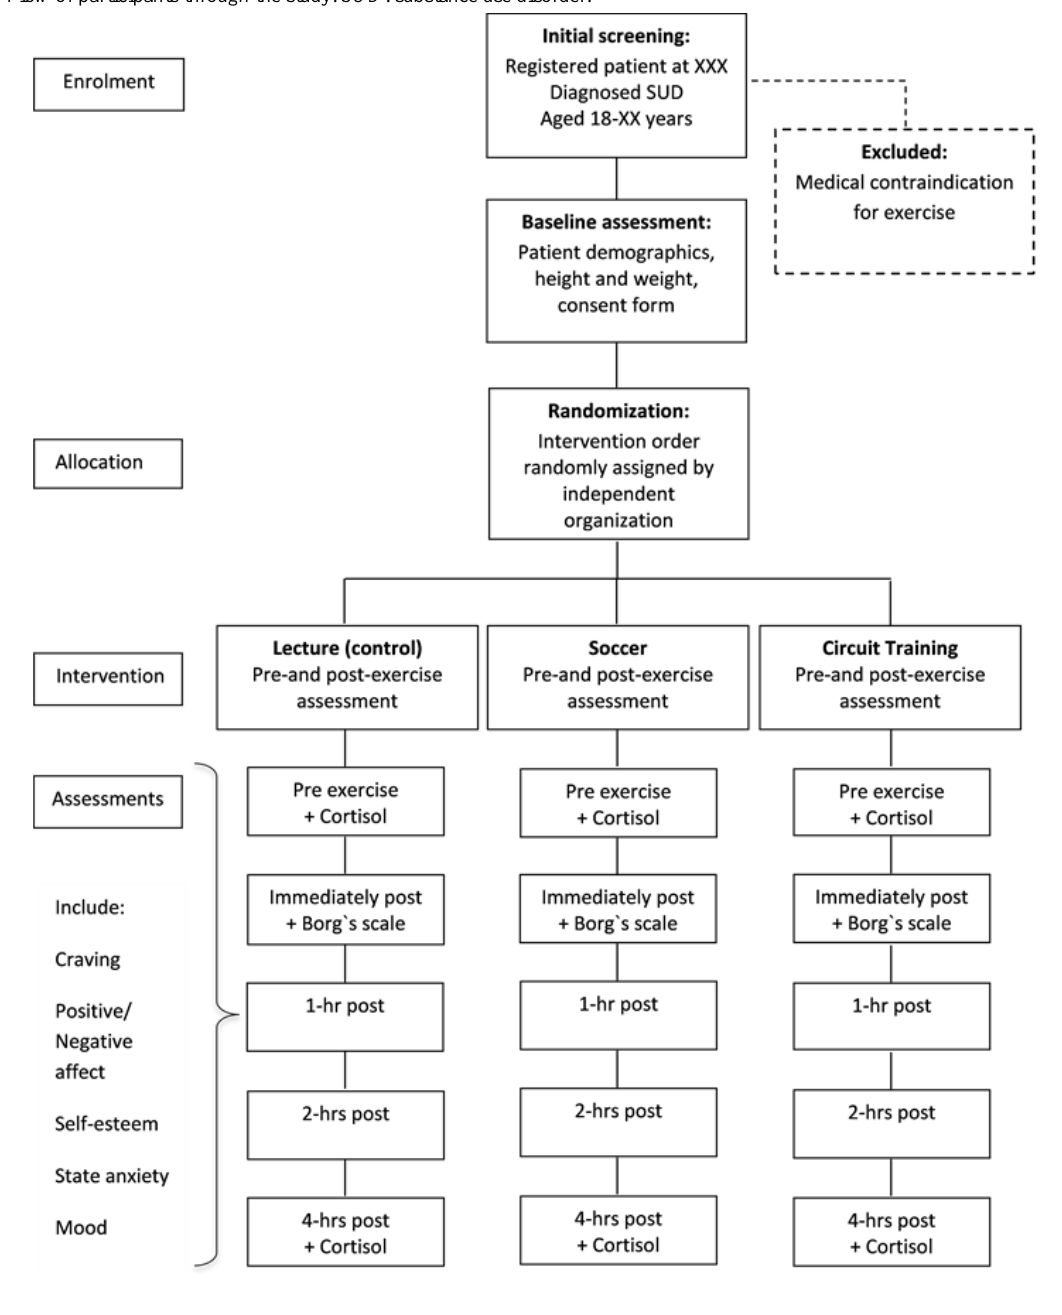
Figure 1. Flow of participants through the study. SUD: substance use